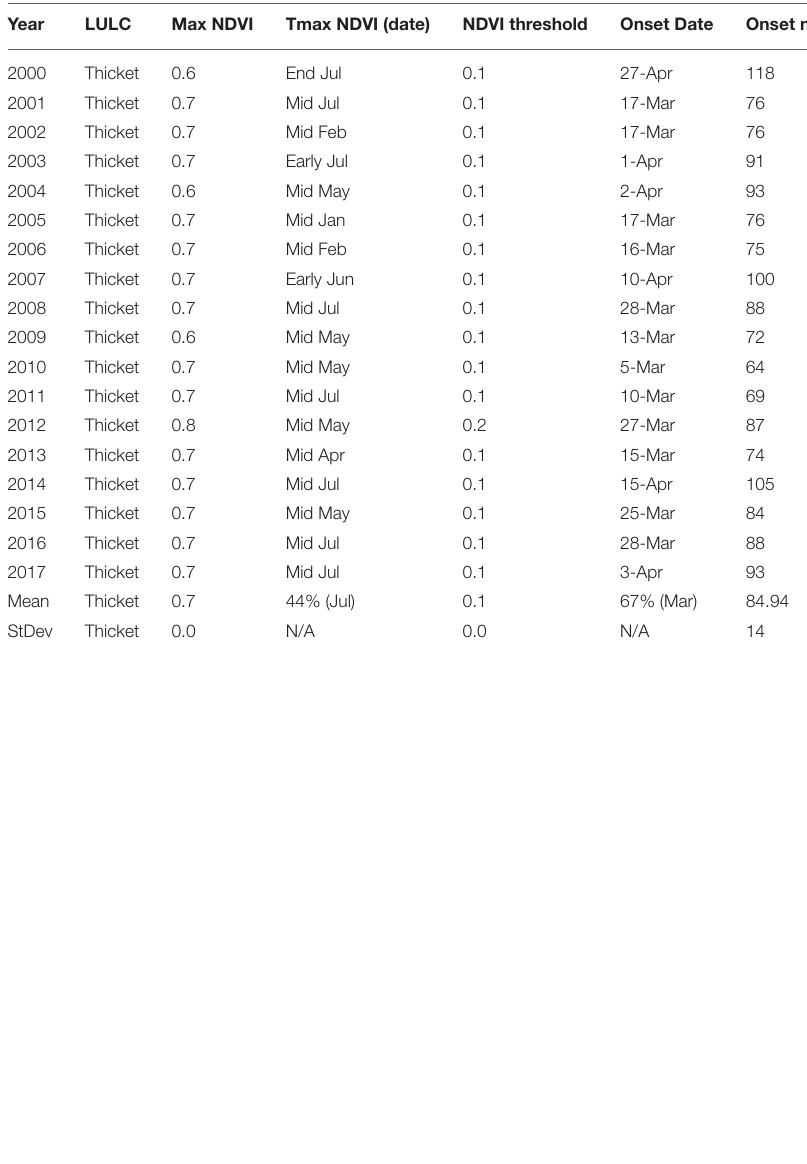
TABLE 5 | Thicket and shrub phenological metrics for the Karamoja region in Uganda for the period